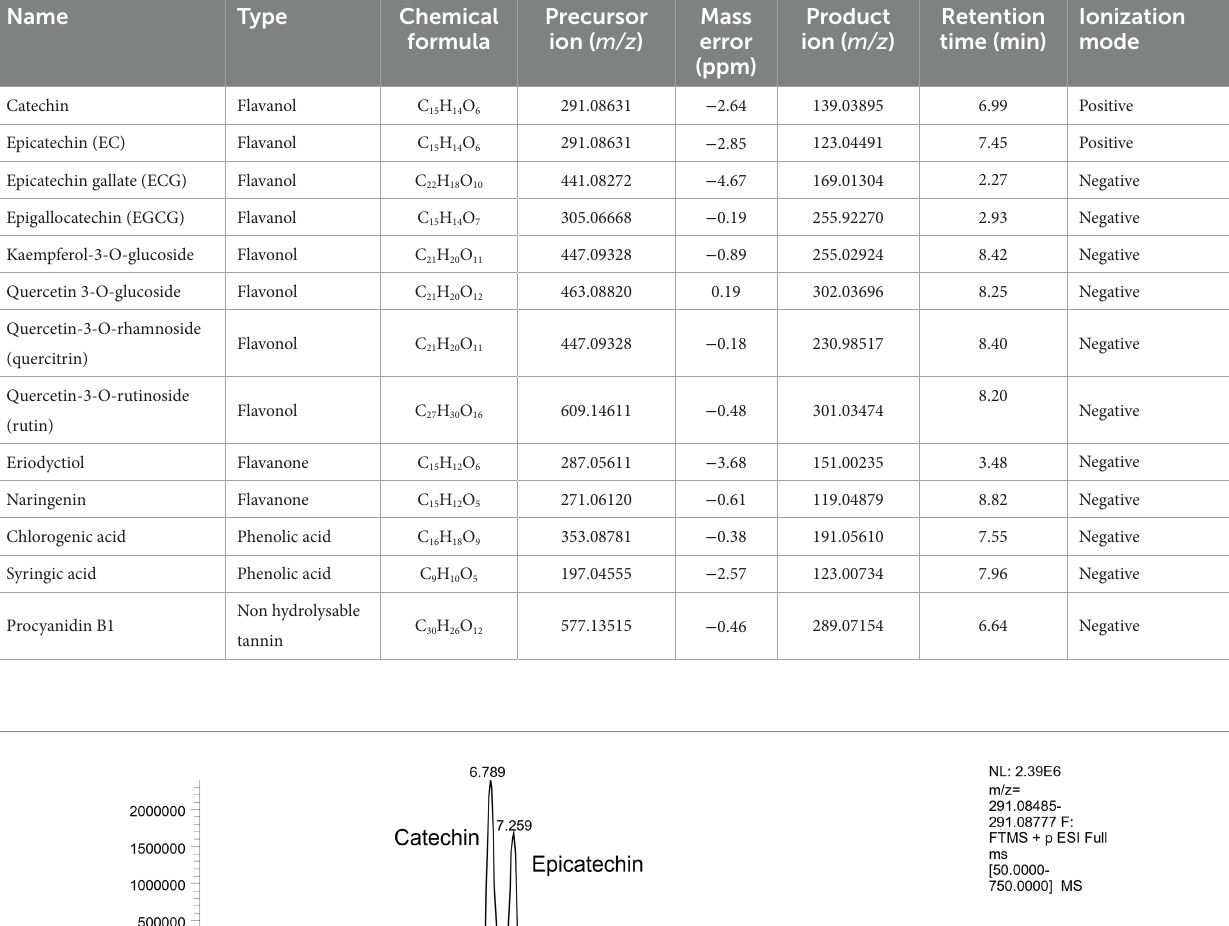
TABLE 3 List of the main phenolic compounds identified in the wine by-products used in the study by UHPLC-Q-Orbitrap-MS.